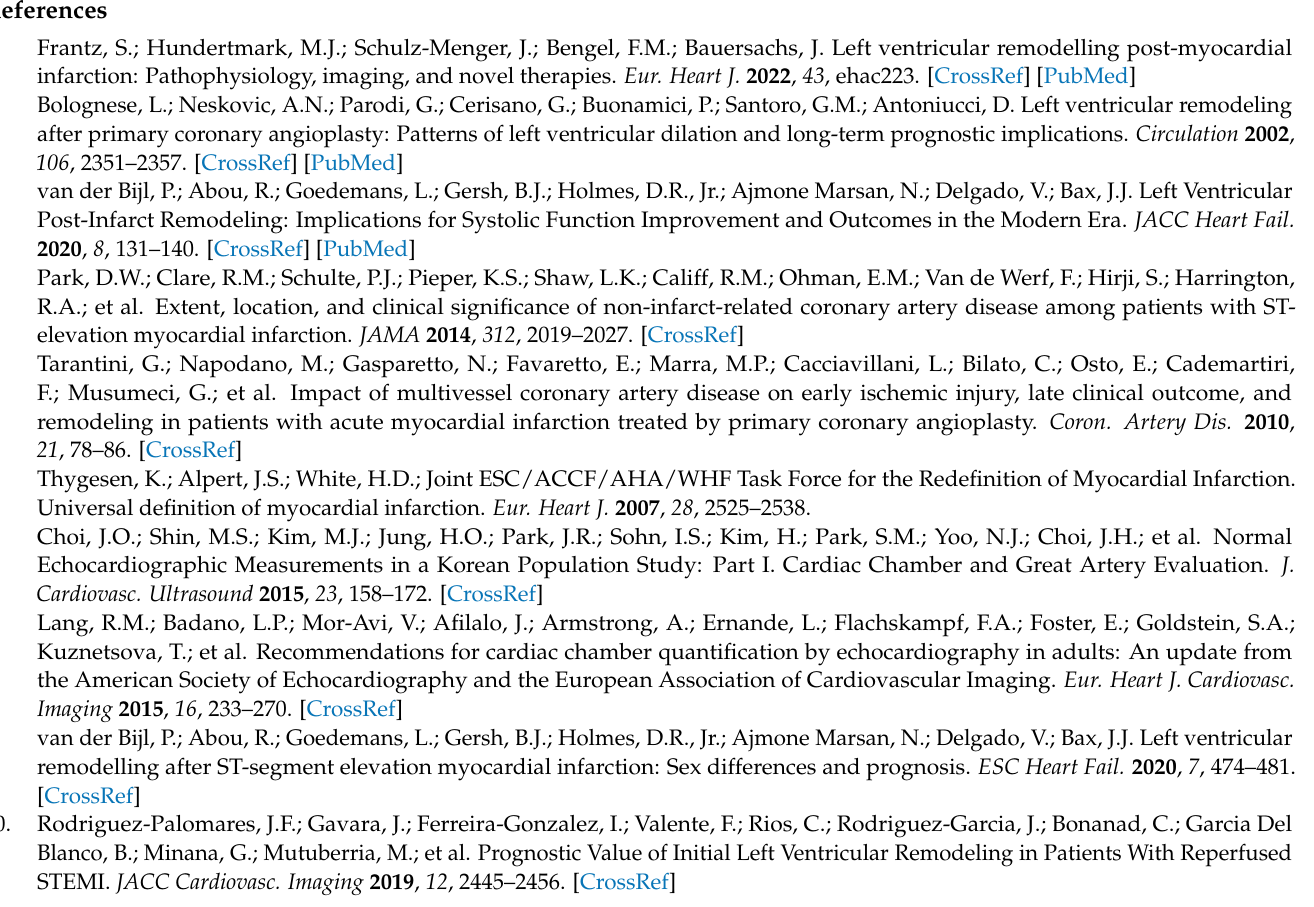
for estimating propensity scores in patients with incomplete revascularization. ES = effect size; Table S2. Comparison before and after IPTW adjustment for the CR group. Table S3. Comparison before and after IPTW adjustment for the IR